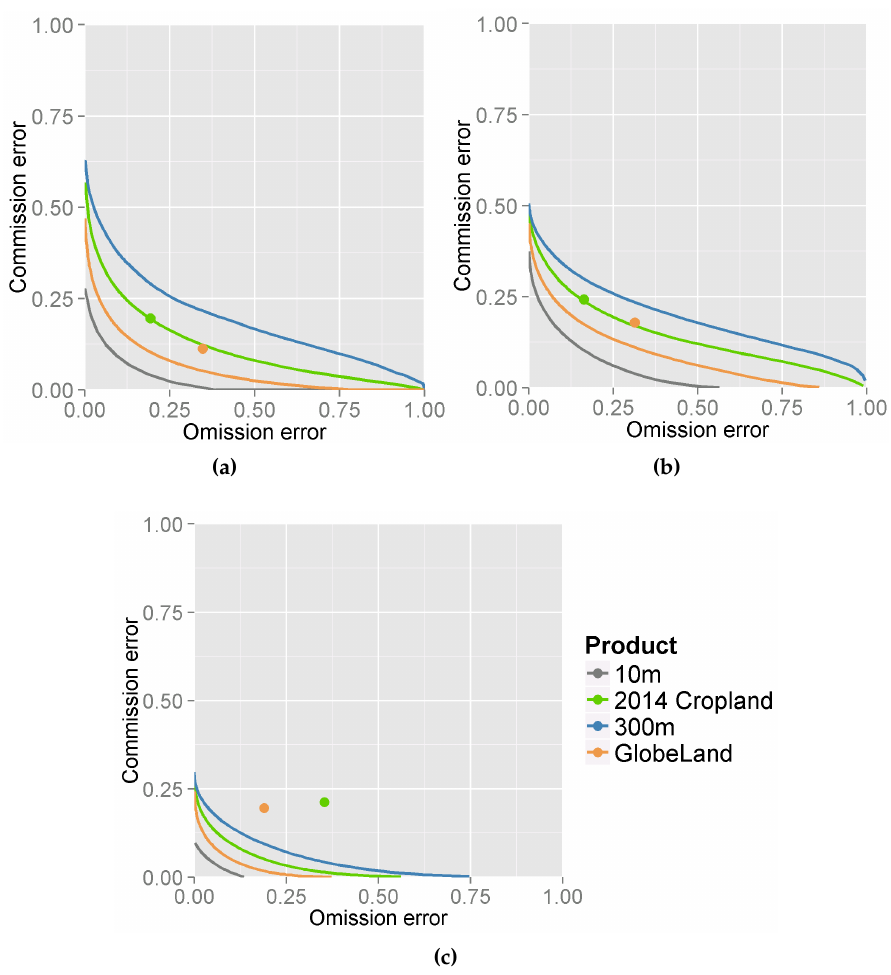
Figure 12. Three examples of Pareto boundary, commission and omission errors for GlobeLand 30 and 2014 Sudano-Sahelian Cropland map . Pareto boundaries were also computed for a 10-m product and a 300-m product. ( a ) Site in center Mali ; ( b ) Site in Sikasso region (Mali South East); ( c ) Site in South